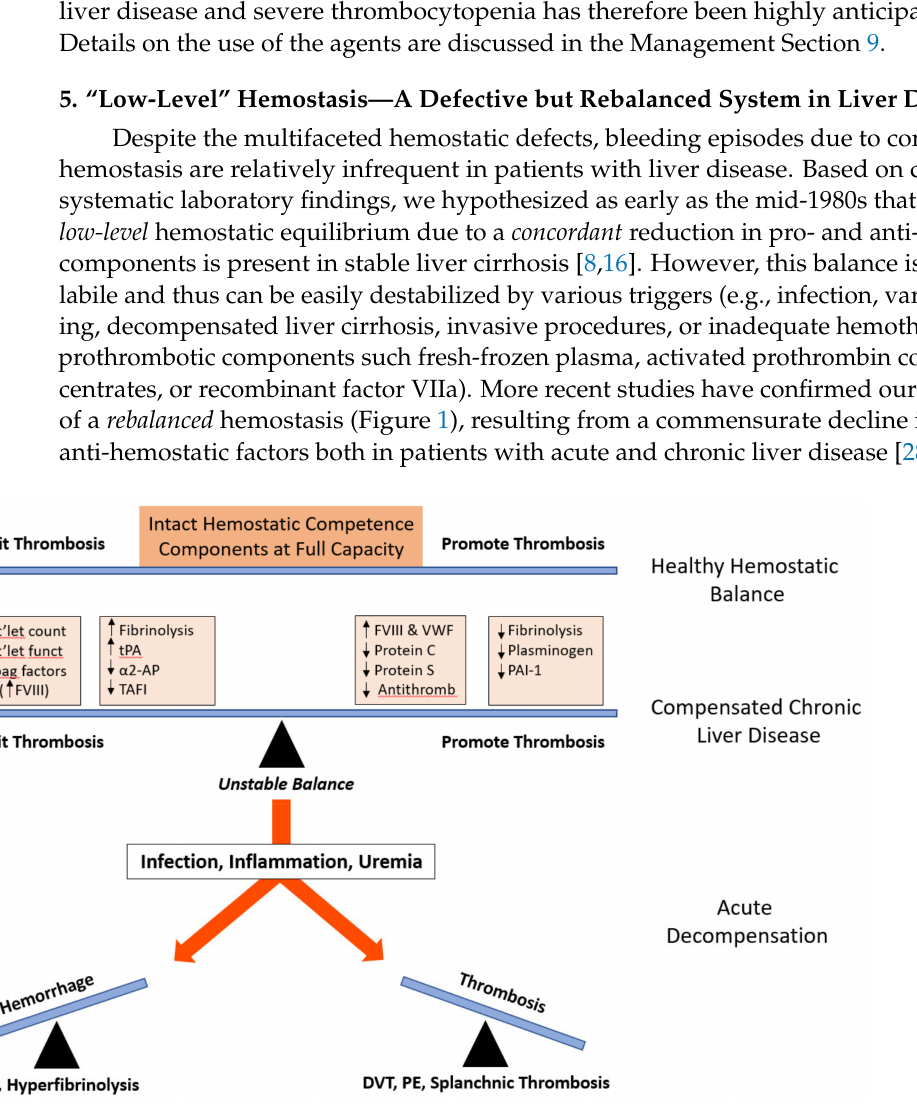
Figure 1. The concept of rebalanced hemostasis in patients with liver disease. In healthy subjects ( A ), hemostasis is in stable equilibrium. In patients with liver disease ( B ), concomitant changes in pro- and antihemostatic components and pathways result in rebalance of the hemostatic apparatus despite the quantitative and qualitative disease-related defects, affecting platelets (primary hemostasis), coagulation (secondary hemostasis), and fibrinolysis. Thus, hemostasis is rebalanced at low level, but the equilibrium now is extremely labile. In patients with decompensated liver disease ( C ) and comorbidities, various stimuli can lead to destabilization and tip the balance toward either bleeding or thrombosis [29]. Modification of a scheme, taken from Eby and Caldwell [31]. Abbreviations: α 2 -AP, α 2 -antiplasmin; Antithromb, antithrombin; DIC, disseminated intravascular coagulation; DVT, deep vein thrombosis; F, factor; PAI-1, plasminogen activator inhibitor-1; PE, pulmonary embolism; Plt’let, platelet; TAFI, thrombin activatable fibrinolysis inhibitor; t-PA, tissue-type plasminogen activator; VWF, von Willebrand